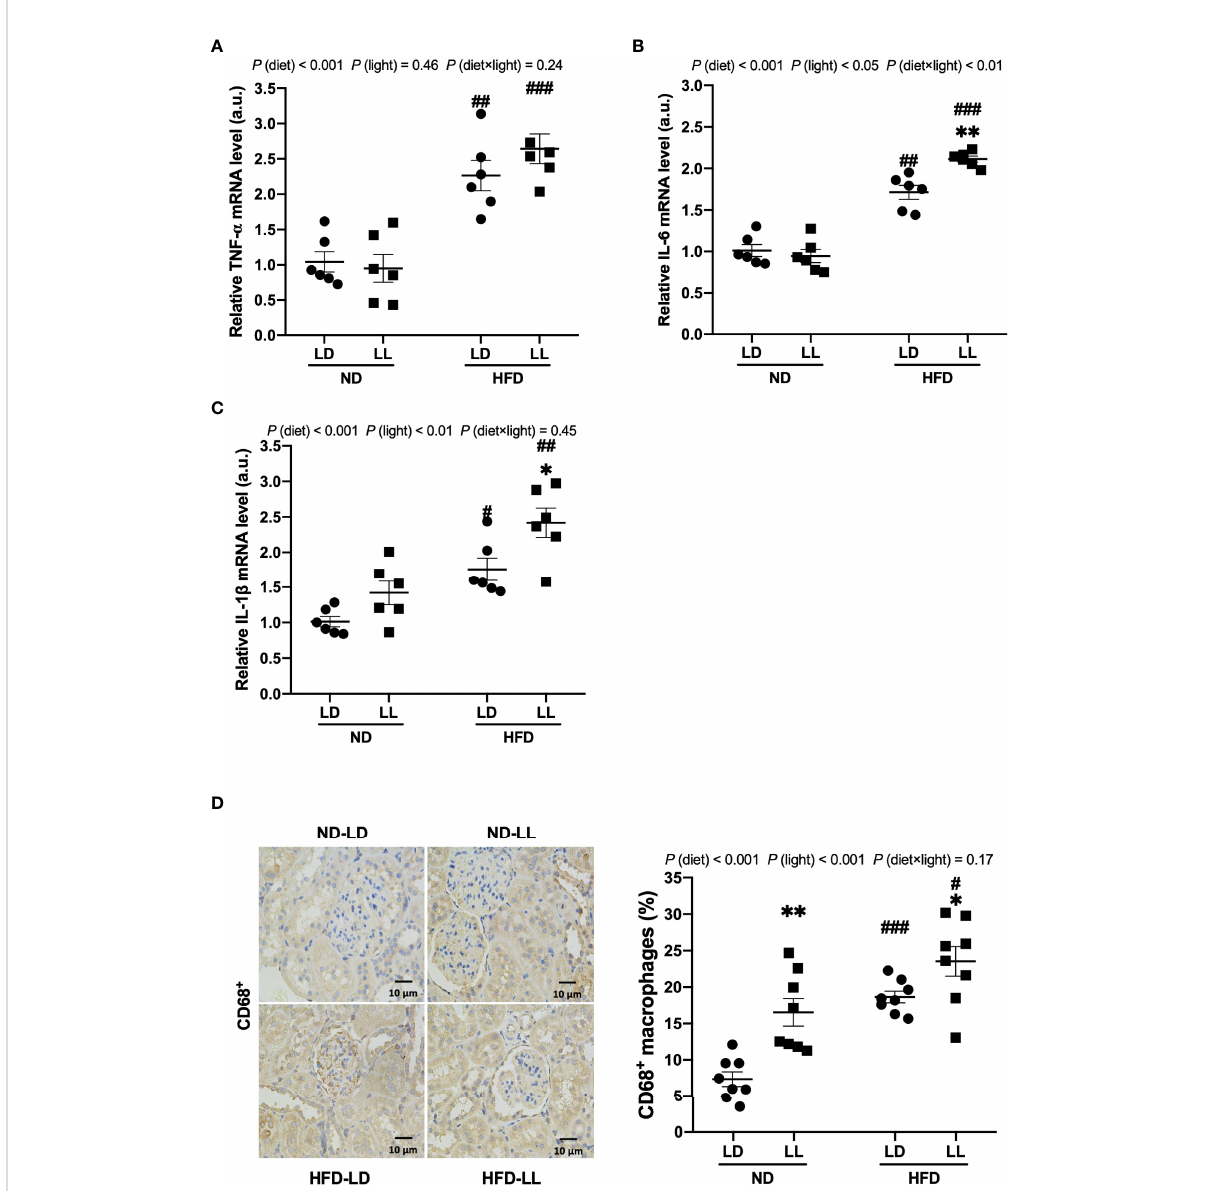
FIGURE 3 Constant light exposure promotes renal in fl ammation in HFD-fed rats. (A – C) Renal mRNA expression of TNF- a , IL-6 and IL-1 b in rats. (D) IHC staining of CD68 and quanti fi cation of CD68 + macrophages. Values represent mean ± SEM (n=6 for A – C , n=8 for D ). Differences were determined using a two-way ANOVA followed by a Bonferroni post hoc analysis. # p <0.05, ## p <0.01, ### p <0.001, vs. ND counterpart. * p <0.05, ** p <0.01, vs. LD counterpart. p (diet), main effect of diet; p (light), main effect of light; p (light × diet), interaction effect of light and